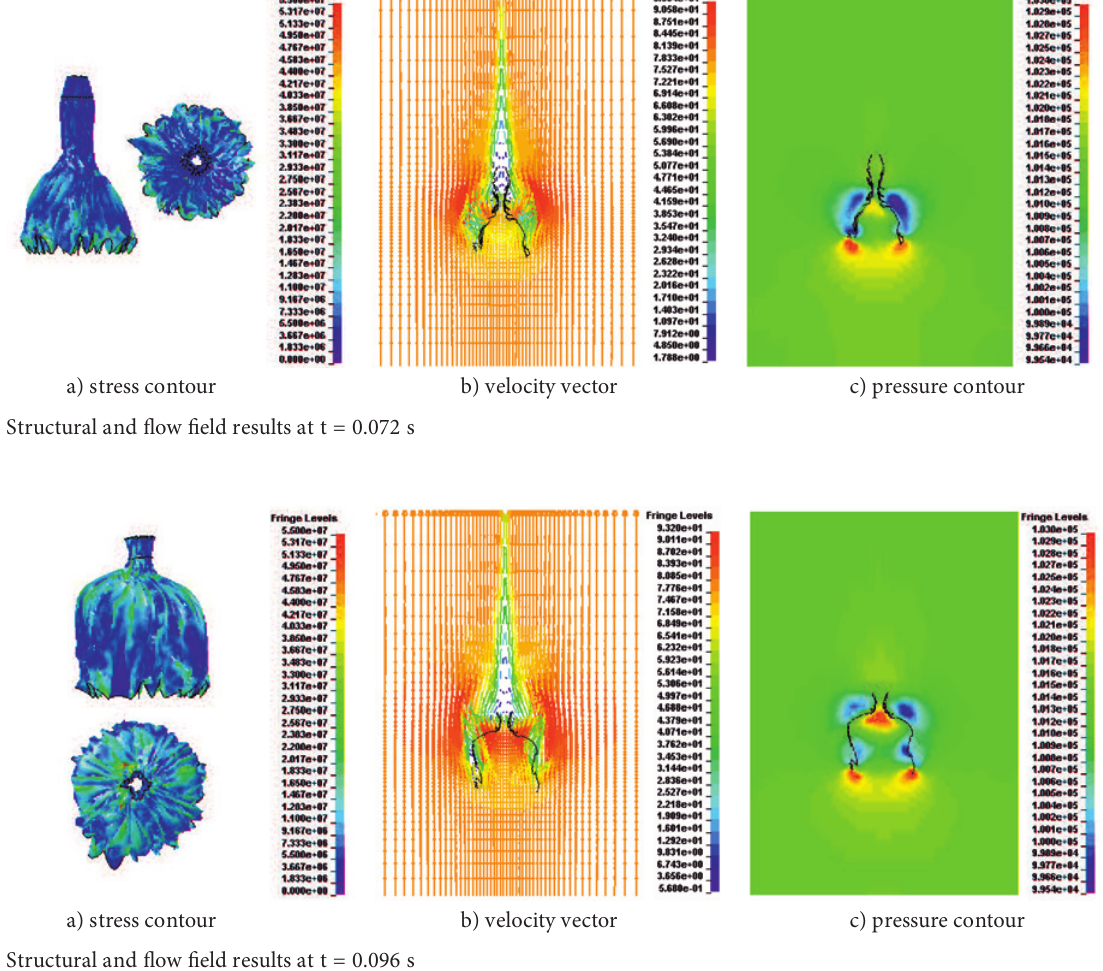
Fig. 5. Structural an d flow fie ld results a t t = 0.096 s